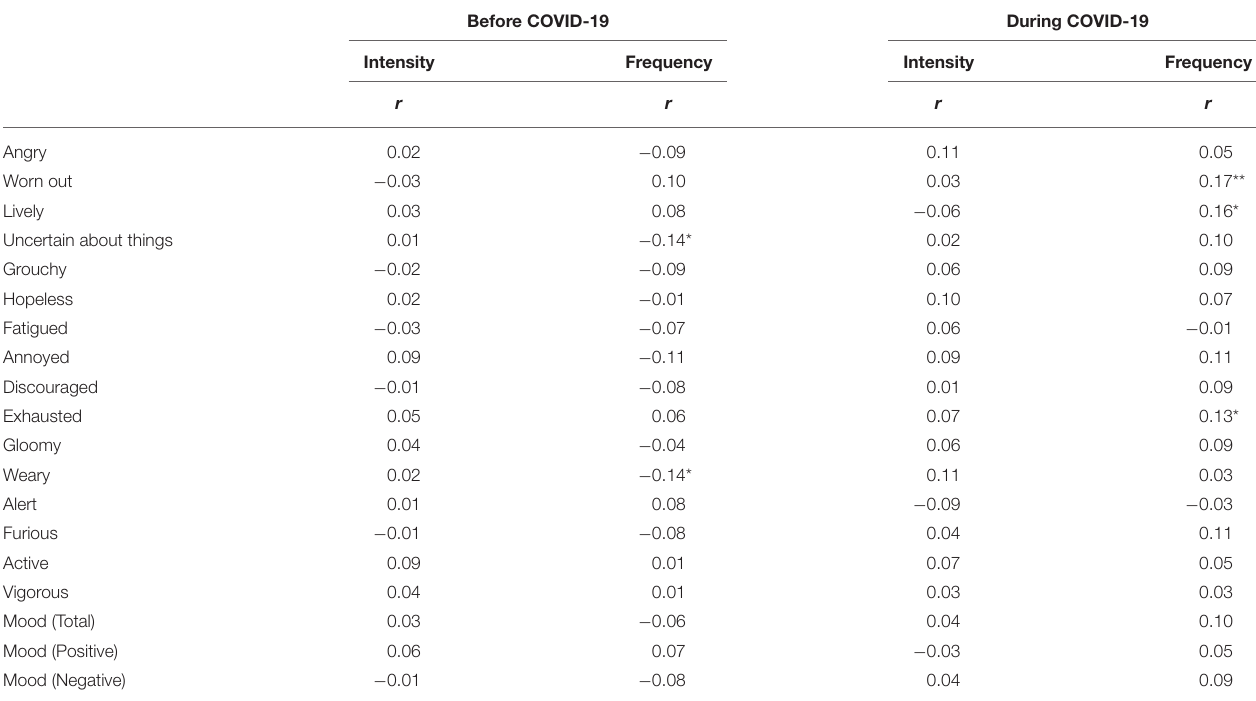
TABLE 4 | Correlation coefficients between PA indices and mood states among males.